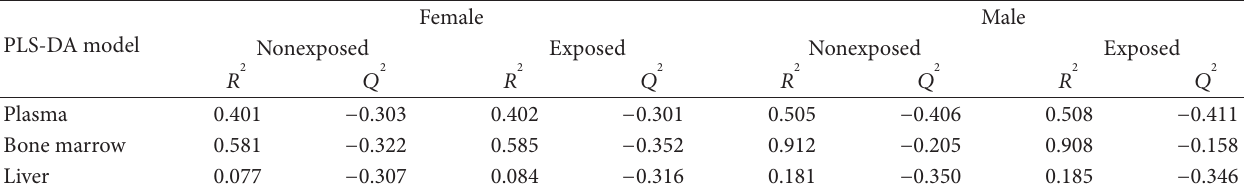
HNMR spectra of plasma samples from nonexposed (blue diamond, 1 ) and exposed males (red circle, 𝑛𝑛 𝑛 𝑛 ) of permutation test for the PLS-DA models. 𝑛